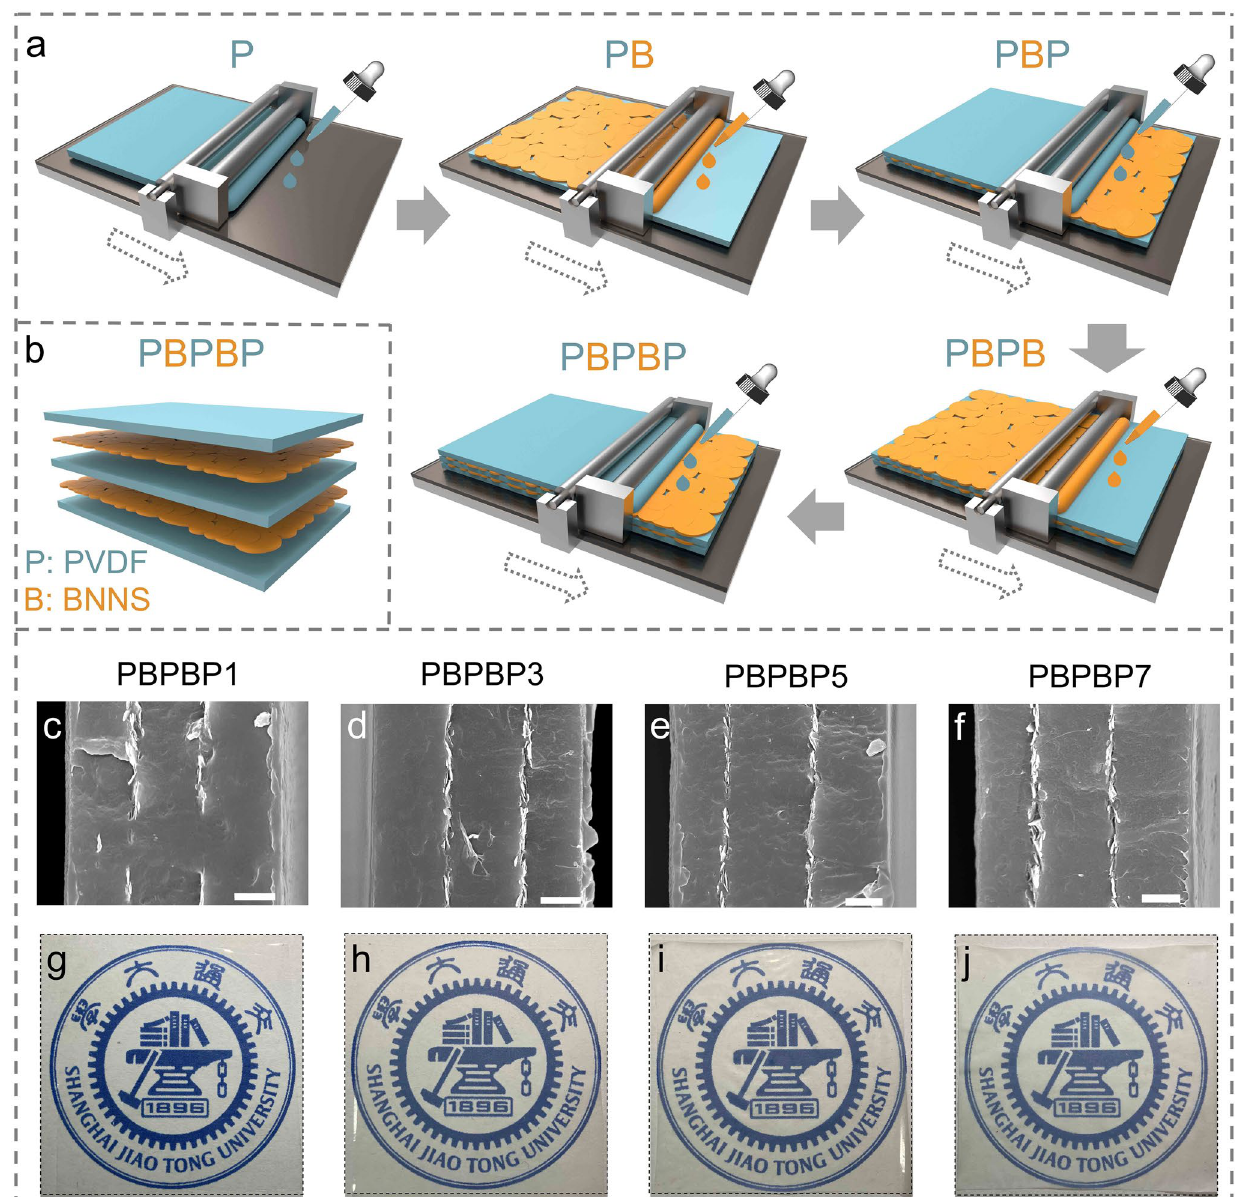
Fig. 2 a Illustration of fabrication process of PBPBP films (P represents the PVDF layer and B is the BNNS layer). b Schematic illustration of PBPBP structure. Cross-sectional SEM images of c PBPBP1, d PBPBP3, e PBPBP5, and f PBPBP7 (the scale bar is 2 μm). Optical pictures of g PBPBP1, h PBPBP3, i PBPBP5, and j